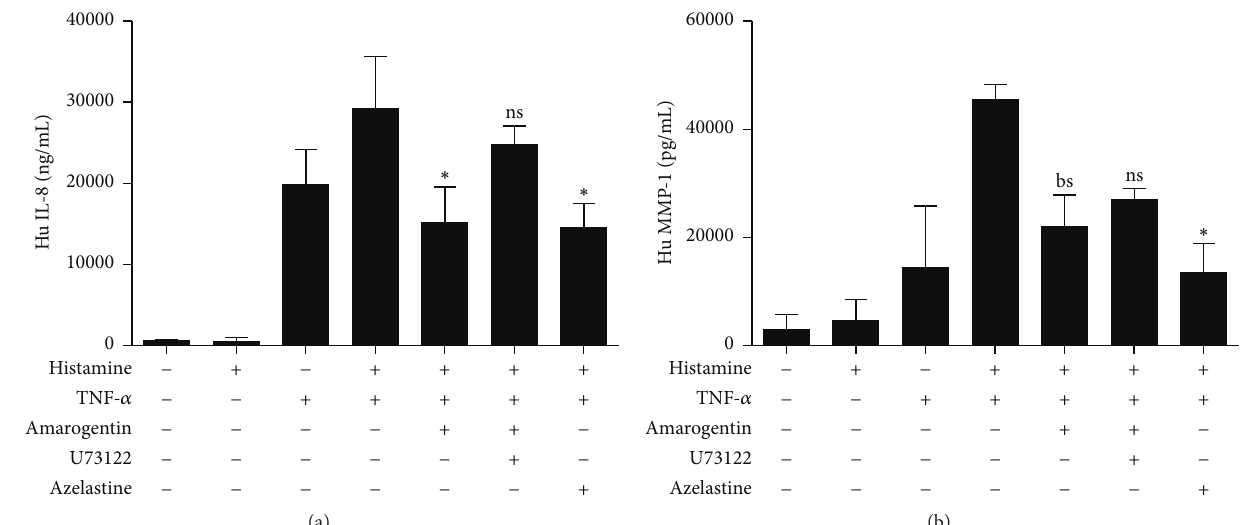
Figure 3: Amarogentin does not inhibit IL-8 and MMP-1 secretion in stimulated HaCaT keratinocytes. HaCaT cells were costimulated with 10 𝜇 M histamine and 25 ng/mL TNF- 𝛼 and preincubated with amarogentin (100 𝜇 M) or azelastine (24 𝜇 M) for 30 minutes. A part of the amarogentin stimulated group was preincubated for 30 min with the PLC inhibitor U73122 (10 𝜇 M). After 24 h IL-8 (a) and MMP-1 (b) expression was assessed in the cell supernatant. The data are shown with standard deviation (SEM) and were analyzed with the unpaired, two-tailed 𝑡 -test ( ∗ 𝑝 < 0.05 ; bs: borderline significant 0.05 < 𝑝 < 0.06 , ns: not statistically significant; 𝑛 = 3 ).